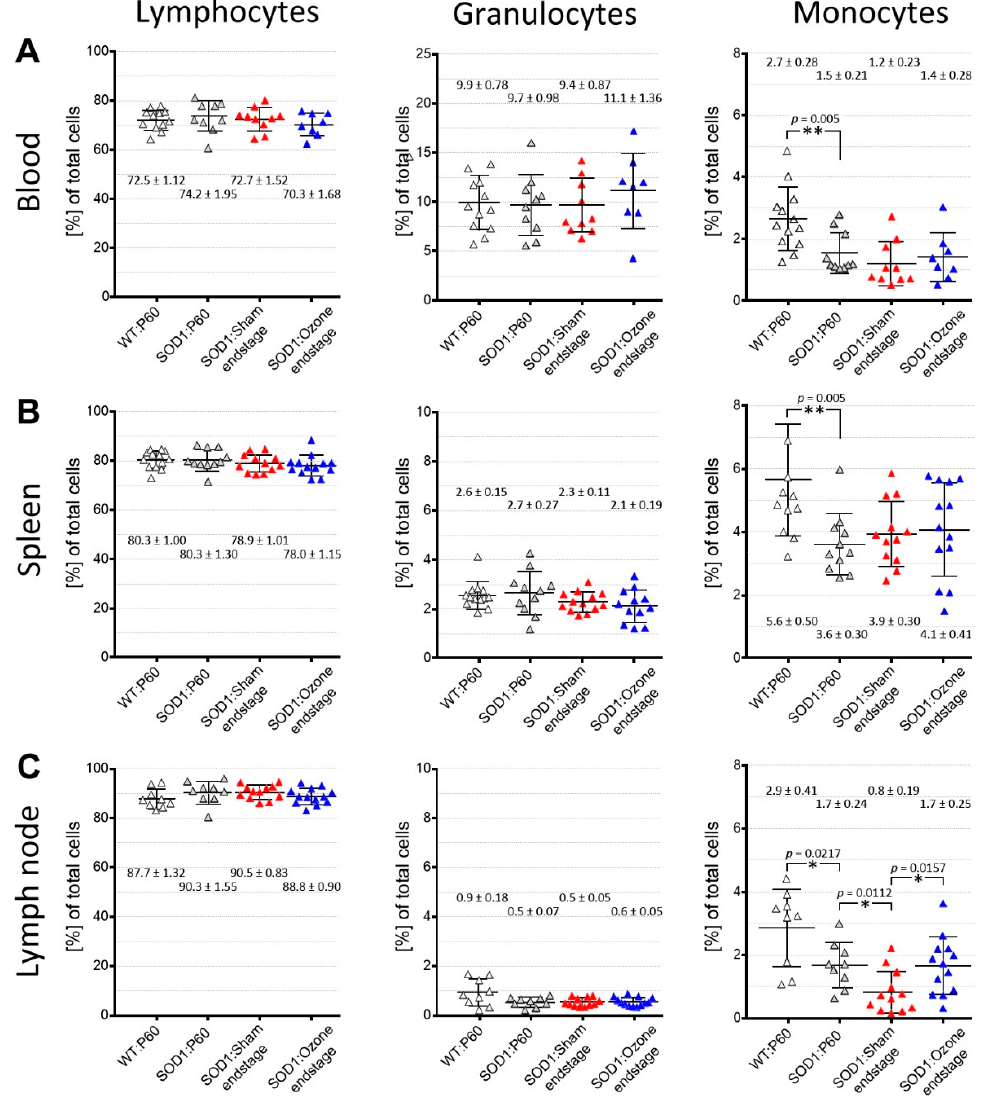
Figure 5. Leukocyte counts in blood, spleen, and mesenteric lymph nodes from WT and SOD1 G93A mice. Leukocytes were isolated from blood ( A ), spleen ( B ), and mesenteric lymph nodes ( C ), and the percentages of lymphocytes, granulocytes, and monocytes were determined by FACS analyses. Isolates derived from sham- and ozone-treated SOD1 G93A mice at the end stage were compared to isolates from wild-type (WT) and SOD1 G93A mice at P60. Scatterplots show the mean values ± standard deviations. An unpaired two-sided t -test was performed for the statistical calculation. Significance level: * p < 0.05; ** p < 0.01.